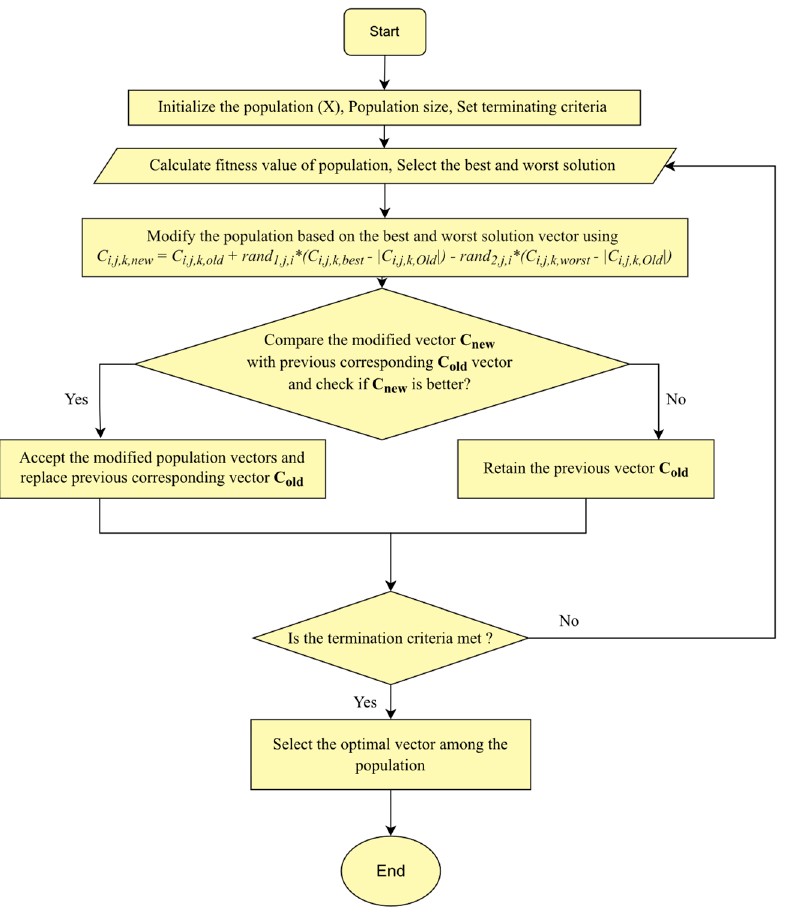
Figure 5. Flow chart of JAYA algorithm.